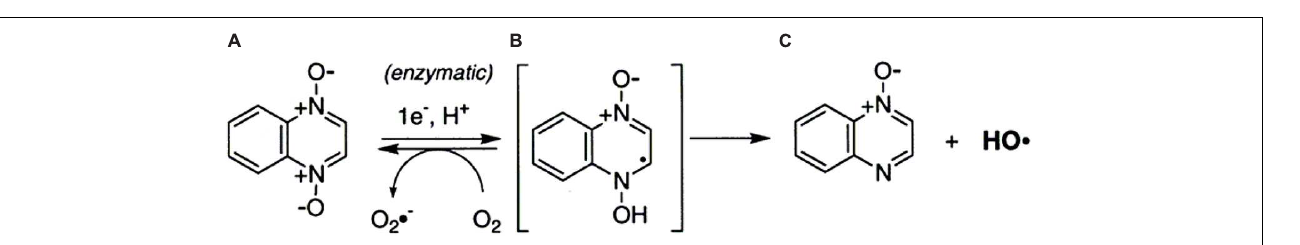
FIGURE 1 | Chemical structures of veterinary-used QdNO antibacterials.